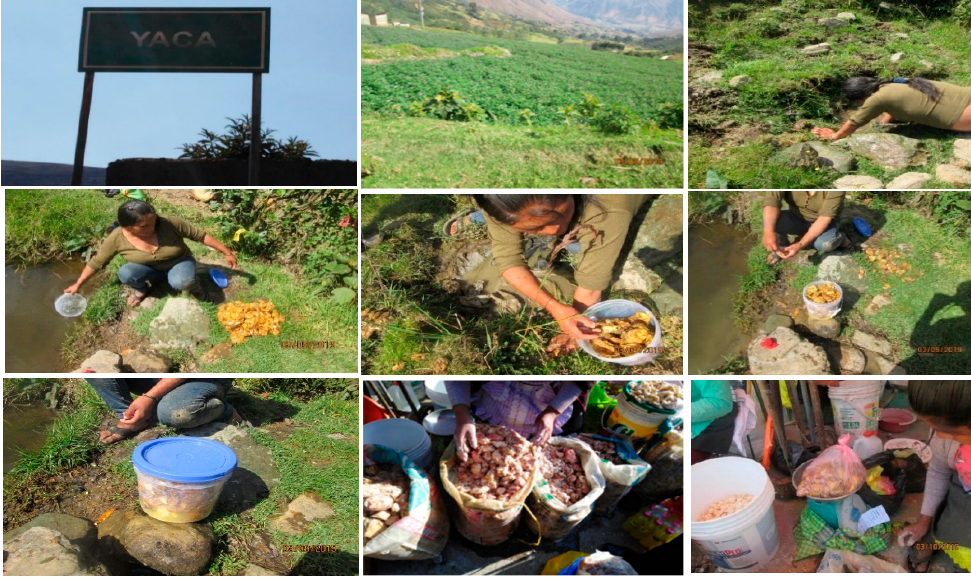
Figure 1. Extraction processing of “potato tocosh” in Yaca district, Huanuco region, Peru.